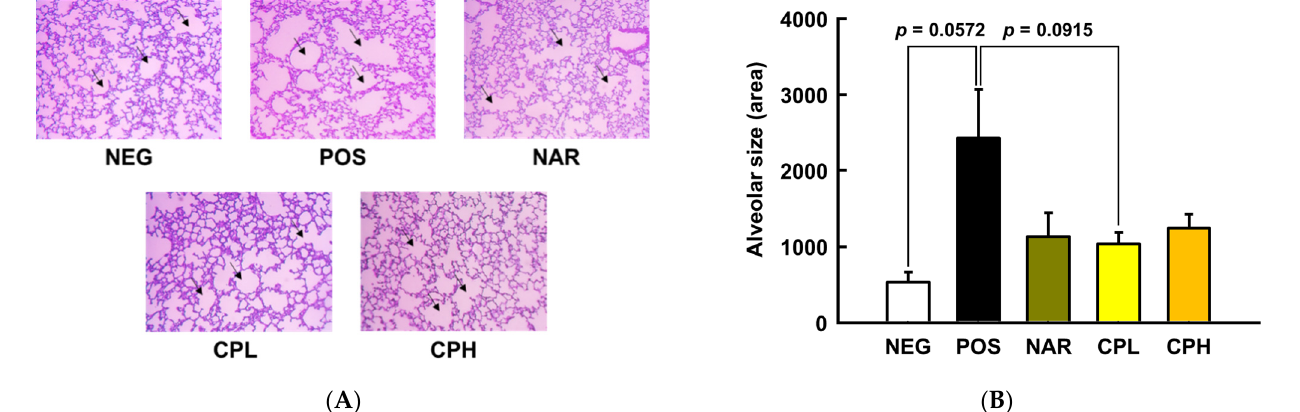
Figure 3. Histological analysis of representative hematoxylin and eosin-stained lung sections, and lung pathology assessment of PM 10 -induced lung damage. ( A ) Hematoxylin and eosin-stained sections; ( B ) alveolar size quantification. All values are expressed as mean ± SEM. CPL, Citrus junos Tanaka peel extract low concentration; CPH, Citrus junos Tanaka peel extract high concentration; NAR, naringin; NEG, negative control; POS, positive control.